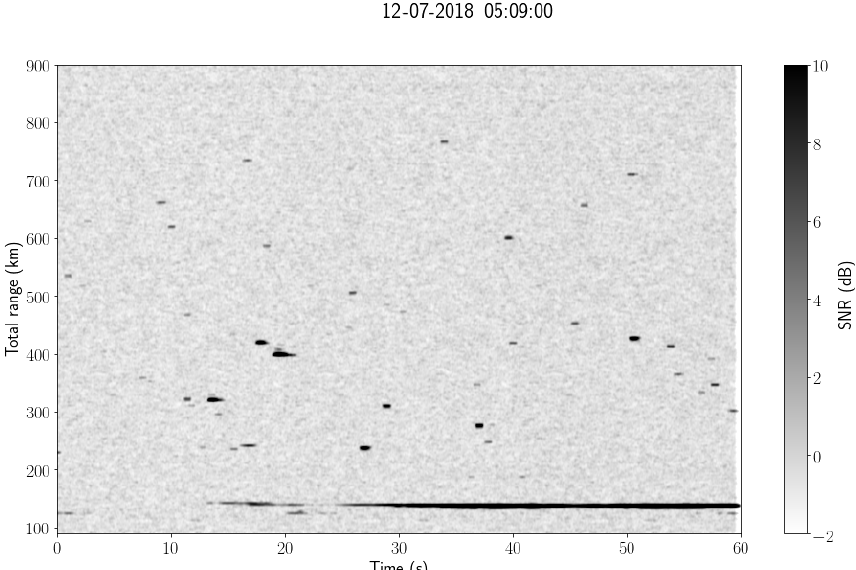
Figure 3. An example of a range–time intensity plot obtained on 12 July 2018 at 05:09UT with MISO-CW. More than 30 specular meteor echoes can be observed, in addition to airplane detection. Note that total range is used, i.e., the range from the transmitter to the echo plus the range from the echo to the